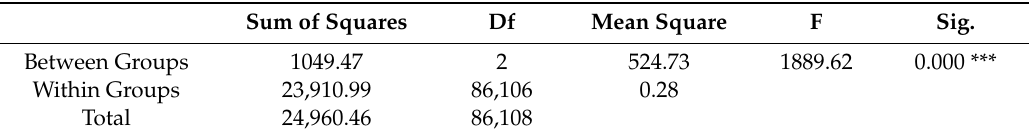
Table 4. The one-way ANOVA table shows the di ff erence of mean air temperature anomaly among the three land-use types (urban, rural, forest).